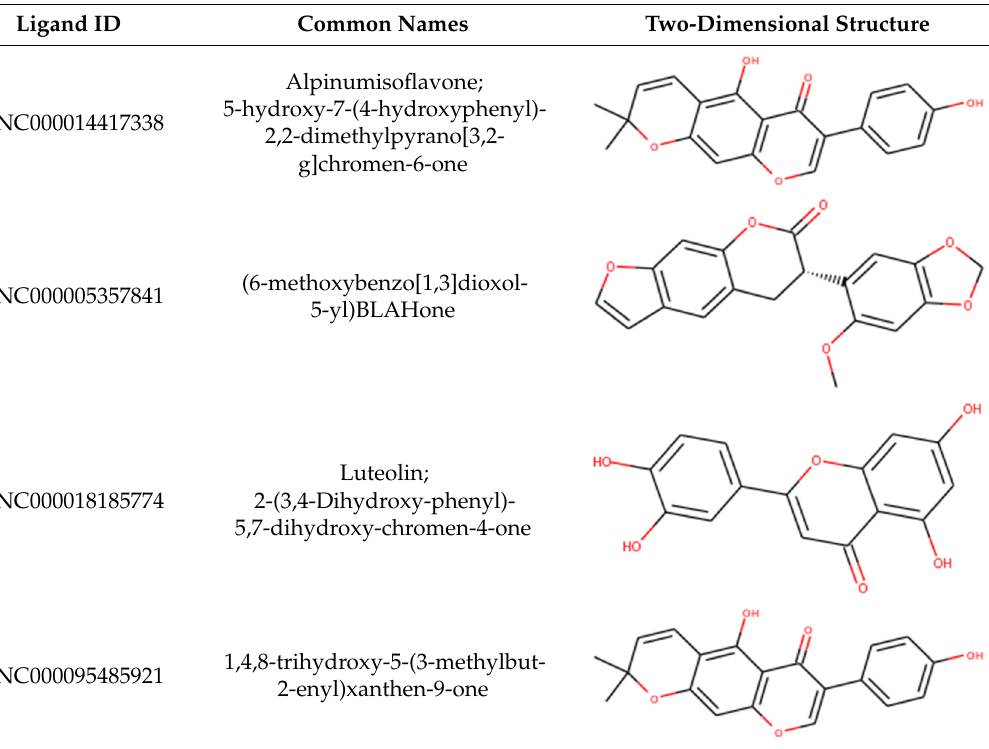
Table 9. List of predicted lead compounds, their common names and two–dimensional structures obtained from Zinc